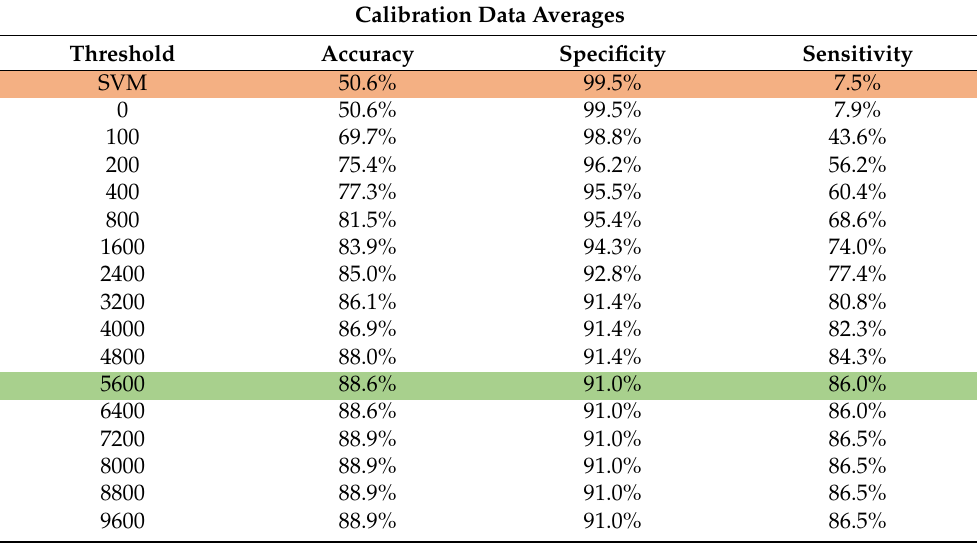
Table 5. Calibration data, with the optimal unburned pixel cluster threshold that was selected highlighted in green and the results from the SVM surface burn classification in